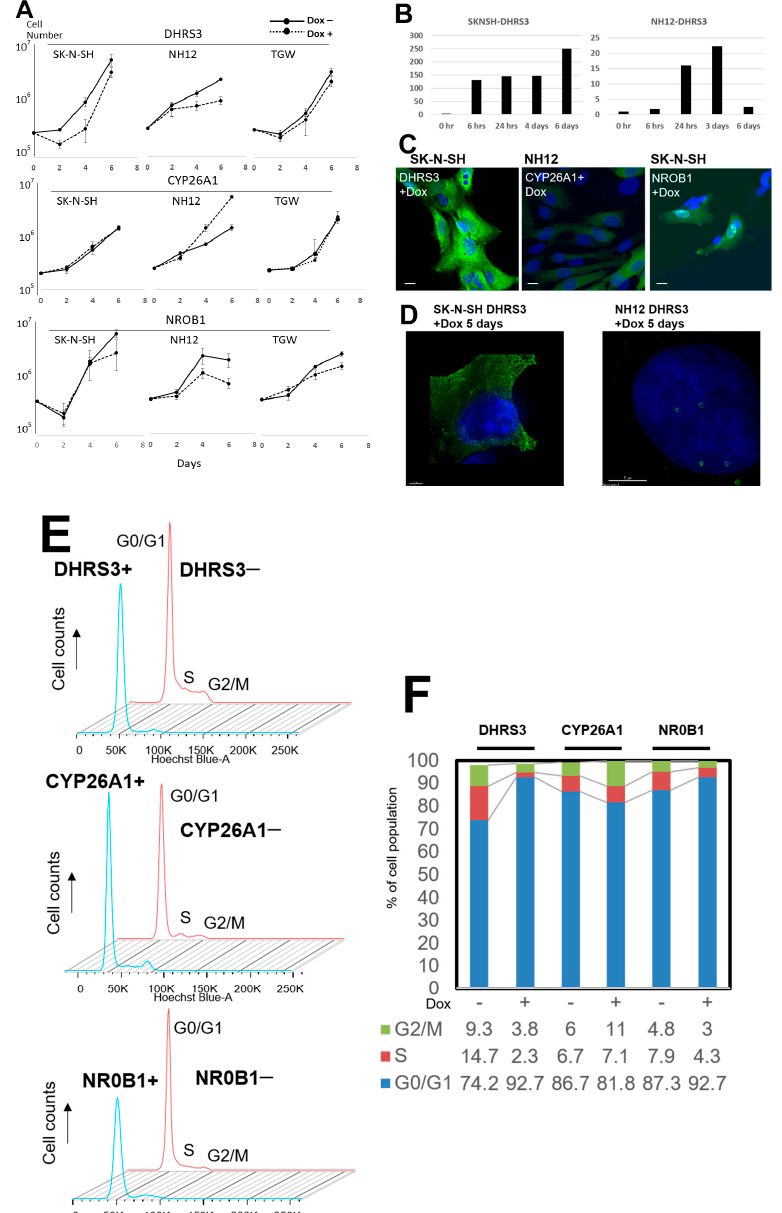
Figure 4. Cell-growth curves of NB cells induced by the Retro-X Tet-On Advanced System. ( A ) Growth curves of NB cell lines. Gene expression was induced with or without doxycycline. ( B ) Time course of the DHRS3 -gene-expression analysis in SK-N-SH and NH12 cells using qPCR. Gene expression of DHRS3 was up-regulated until 3–6 days after Dox induction. ( C ) Immunofluorescent imaging of gene expression using the mouse-specific FLAG-M2 monoclonal antibody. Expression of each gene was obvious in all cell lines 5 days after Dox induction, but expression of DHRS3 decreased at 7 and 9 days after Dox induction. Scale bar is 5 µm. ( D ) Morphological alterations of SK-N-SH and NH-12 cells at 5 days after Dox induction. SK-N-SH and NH12 cells showed cellular enlargement. Expression of DsRed corresponded to inserted gene expression. ( E ) Cell-cycle analysis using flow cytometry in SK-N-SH cells; G0/G1 arrest was detected in Dox-induced DHRS3-expressing (DHRS3+) and NROB1-expressing (NROB1+) cells, but not in CYP26A1-expressing (CYP26A1+) cells. ( F ) Percentages of cells in G0/G1, S, and G2/M for the cells with or without Dox induction of each gene. Reductions in the percentages of S and G2/M were detected in the SK-N-SH DHRS3+ and NROB1+ cells, but not in CYP26A1+